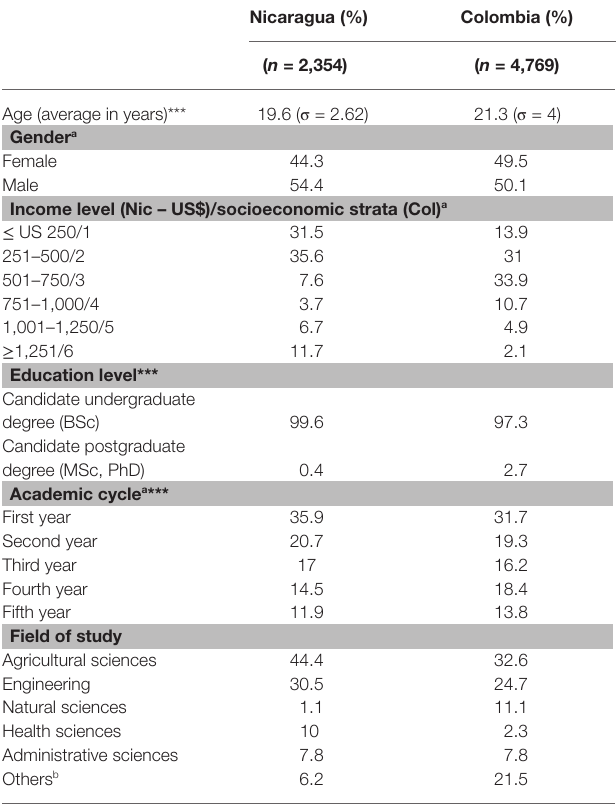
TABLE 1 | Educational and sociodemographic characteristics of the study population in Nicaragua and Colombia.